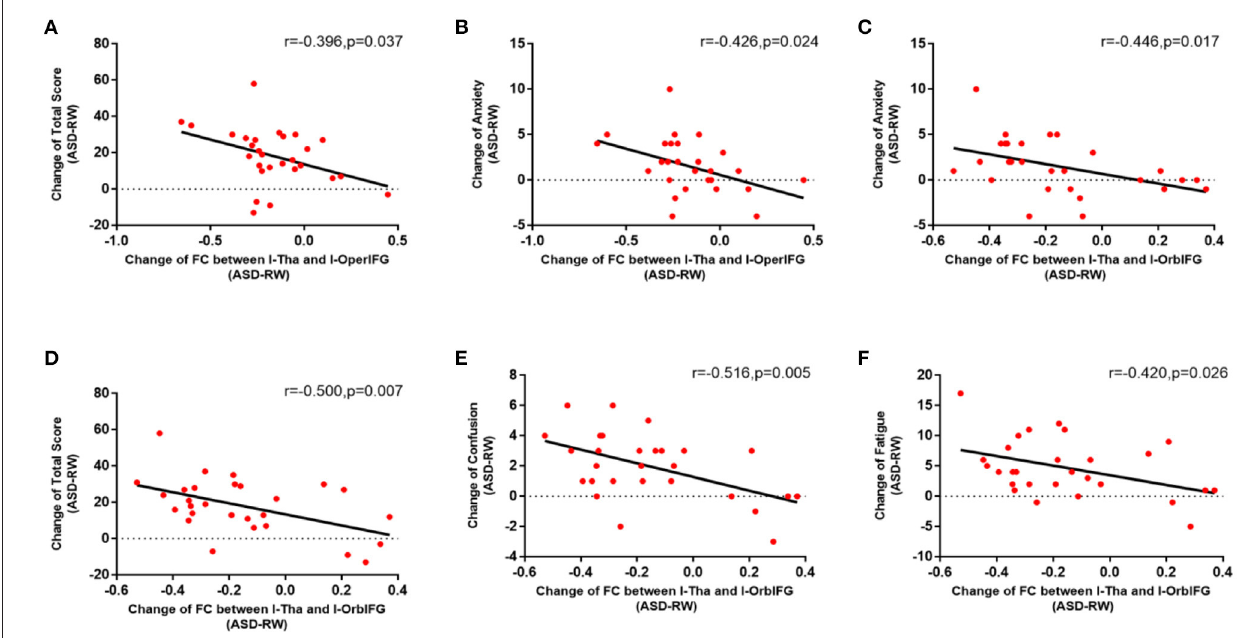
FIGURE 4 | Relation of functional connectivity between left thalamus and other brain regions to emotion changes following acute sleep deprivation (ASD > RW, n = 28). The decrease in functional connectivity between l-Tha and l-OperIFG (A) , between l-Tha and l-OrbIFG (D) was significantly negatively correlated with the Change of total score of the POMS. The decrease in functional connectivity between l-Tha and l-OperIFG (B) , between l-Tha and l-OrbIFG (C) was significantly negatively correlated with the change of anxiety. The decrease in functional connectivity between l-Tha and l-OrbIFG (E,F) was significantly negatively correlated with the change of confusion and fatigue. FC, functional connectivity; ASD, acute sleep deprivation; RW, rested wakefulness; l-Tha, left thalamus; l-OperIFG, left opercular inferior frontal gyrus; l-OrbIFG, left orbital inferior frontal gyrus.